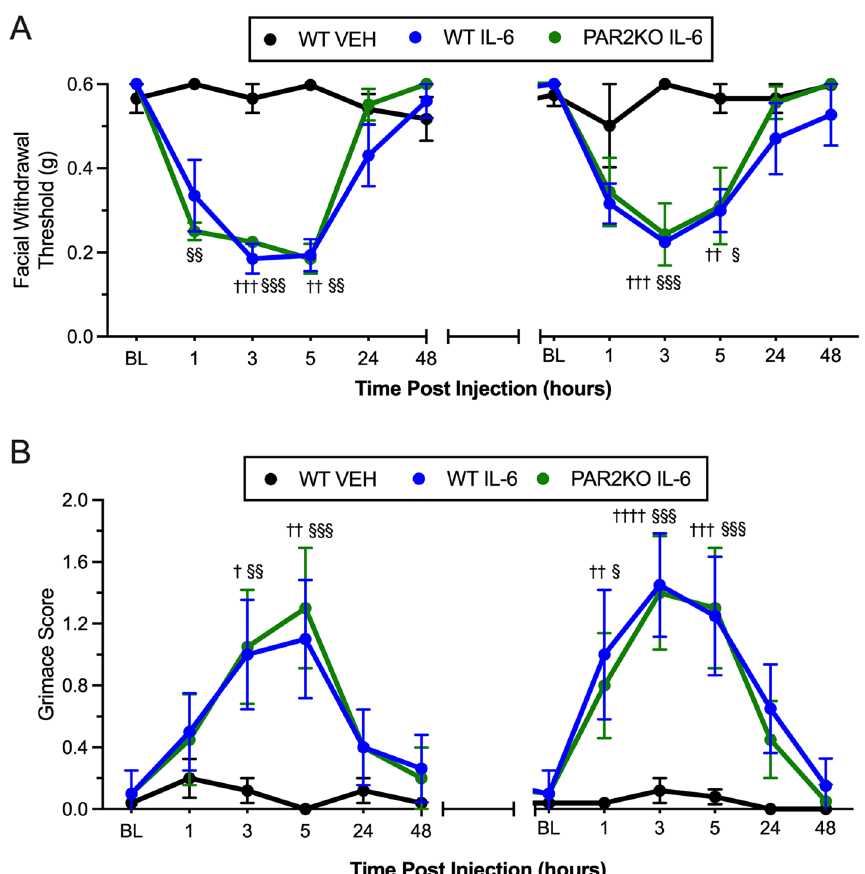
Fig. 5 Dural IL-6 causes hyperalgesic priming to GTN in the absence of PAR2 . A Facial withdrawal thresholds in PAR2KO mice following treatment with IL-6 ( n 4), WT controls ( n 4) following treatment of IL-6, and WT controls following treatment with vehicle and subthreshold GTN. Note that there = = are 12 days between the last time point of 48 h on the left and the baseline for GTN administration, indicated by the broken x-axis (see Fig. 1C). Application of IL-6 significantly decreased withdrawal thresholds in both WT (†) and PAR2KO (§) mice and enhanced hyperalgesic priming to GTN compared to WT mice treated with vehicle. B Grimace scores of PAR2KO mice and their WT controls following treatment with IL-6 and GTN. IL-6 significantly increased grimacing in WT and PAR2KO mice compared to WT mice treated with vehicle. There is no significant difference in grimacing between Par2KO and WT mice treated with IL-6. †,§ p < 0.05, ††,§§ p < 0.01, †††,§§§ p < 0.001, †††† p < 0.0001. Data are represented as mean